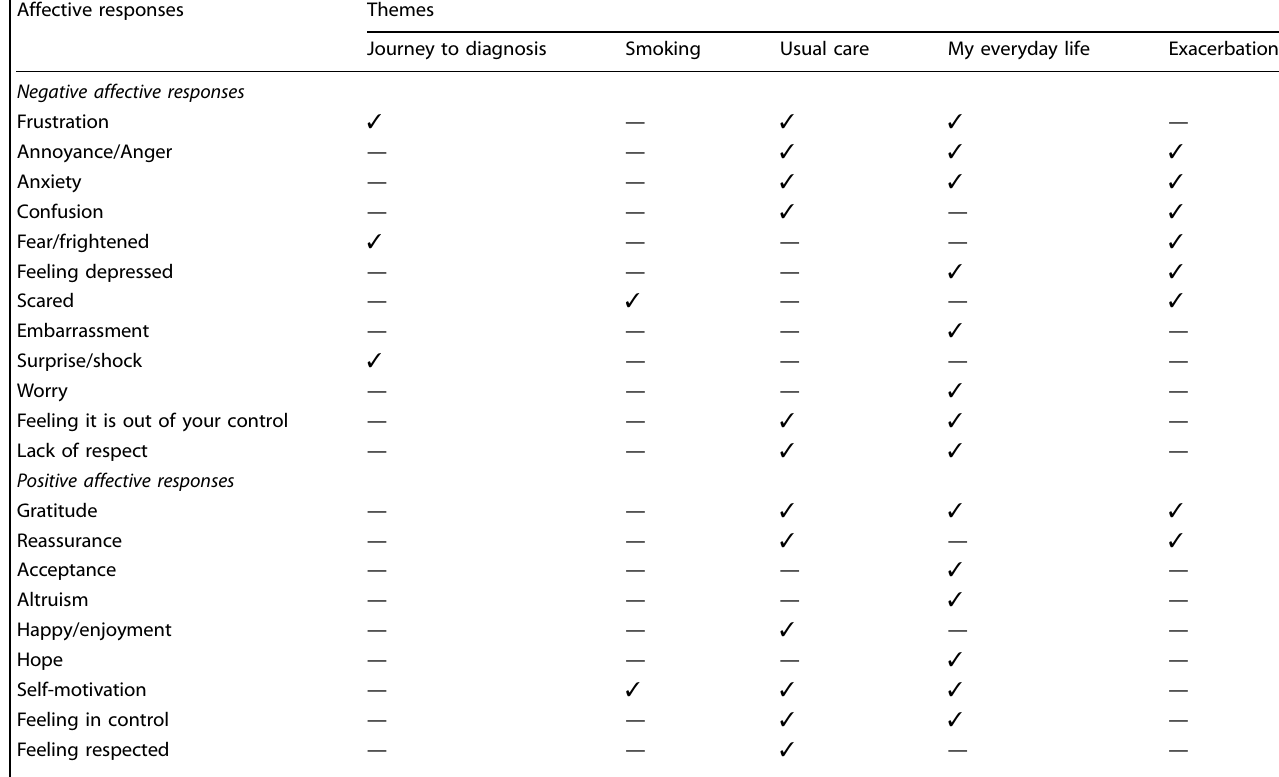
Table 2. Summary of affective responses and themes Affective